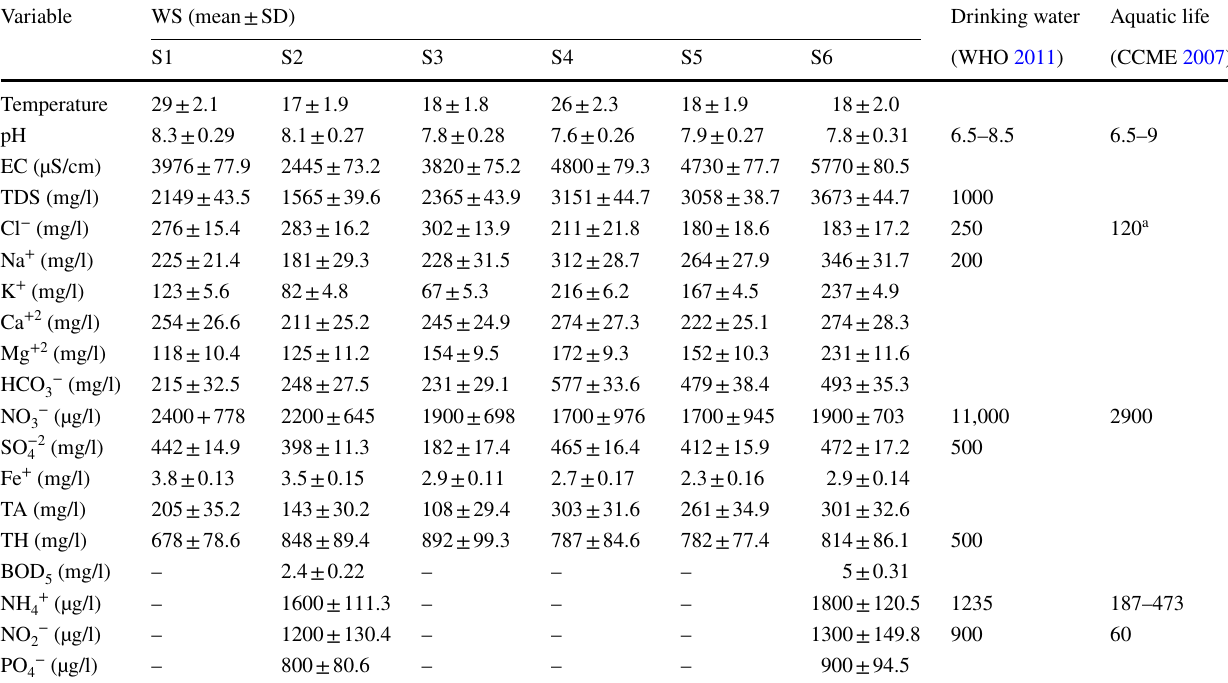
Table 2 Water quality parameters values of Shatt Al-Arab River and comparative guidelines during the wet season